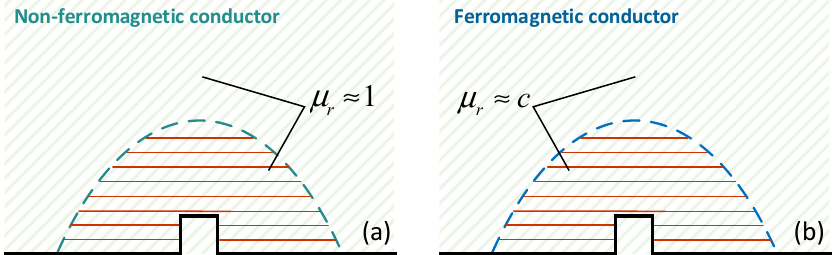
Figure 1. Traditional view of the magnetic permeability in the MB-ECT method. ( a ) non-ferromagnetic material, ( b ) ferromagnetic material.